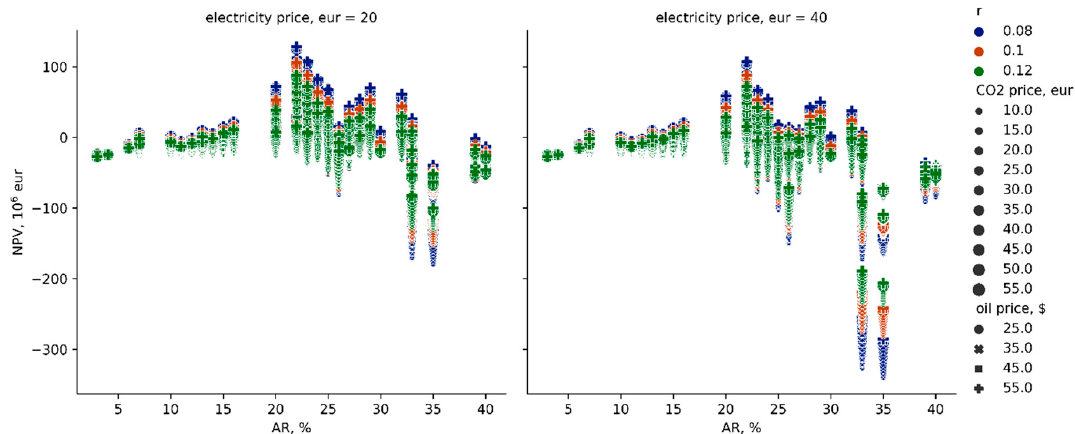
electricity prices (compression costs).